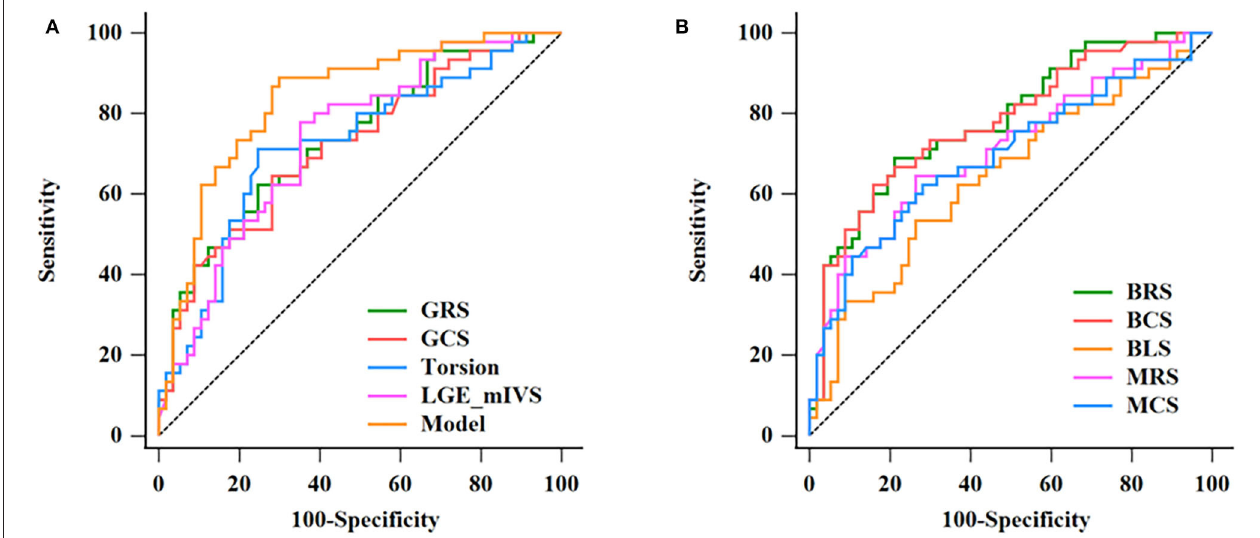
FIGURE 4 | Discrimination of HCM and HHD by CMR parameters. The ROC curves in discrimination between HCM and HHD for single CMR parameters and the multivariate regression model are given in Table 5 (A) . The AUC of combination model was the highest (0.835). The ROC curves of BRS, BCS, BLS, MRS, MCS in discrimination between HCM and HHD group (B) . HCM, hypertrophic cardiomyopathy; HHD, hypertensive heart disease; ROC, receiver operating characteristic; CMR, cardiovascular magnetic resonance; AUC, area under the curve; GRS, global radial strain; GCS, global circumferential strain; LGE, late gadolinium enhancement; mIVS, mid interventricular septum; BRS, basal radial strain; BCS, basal circumferential strain; BLS, basal longitudinal strain; MRS, mid radial strain; MCS, mid circumferential